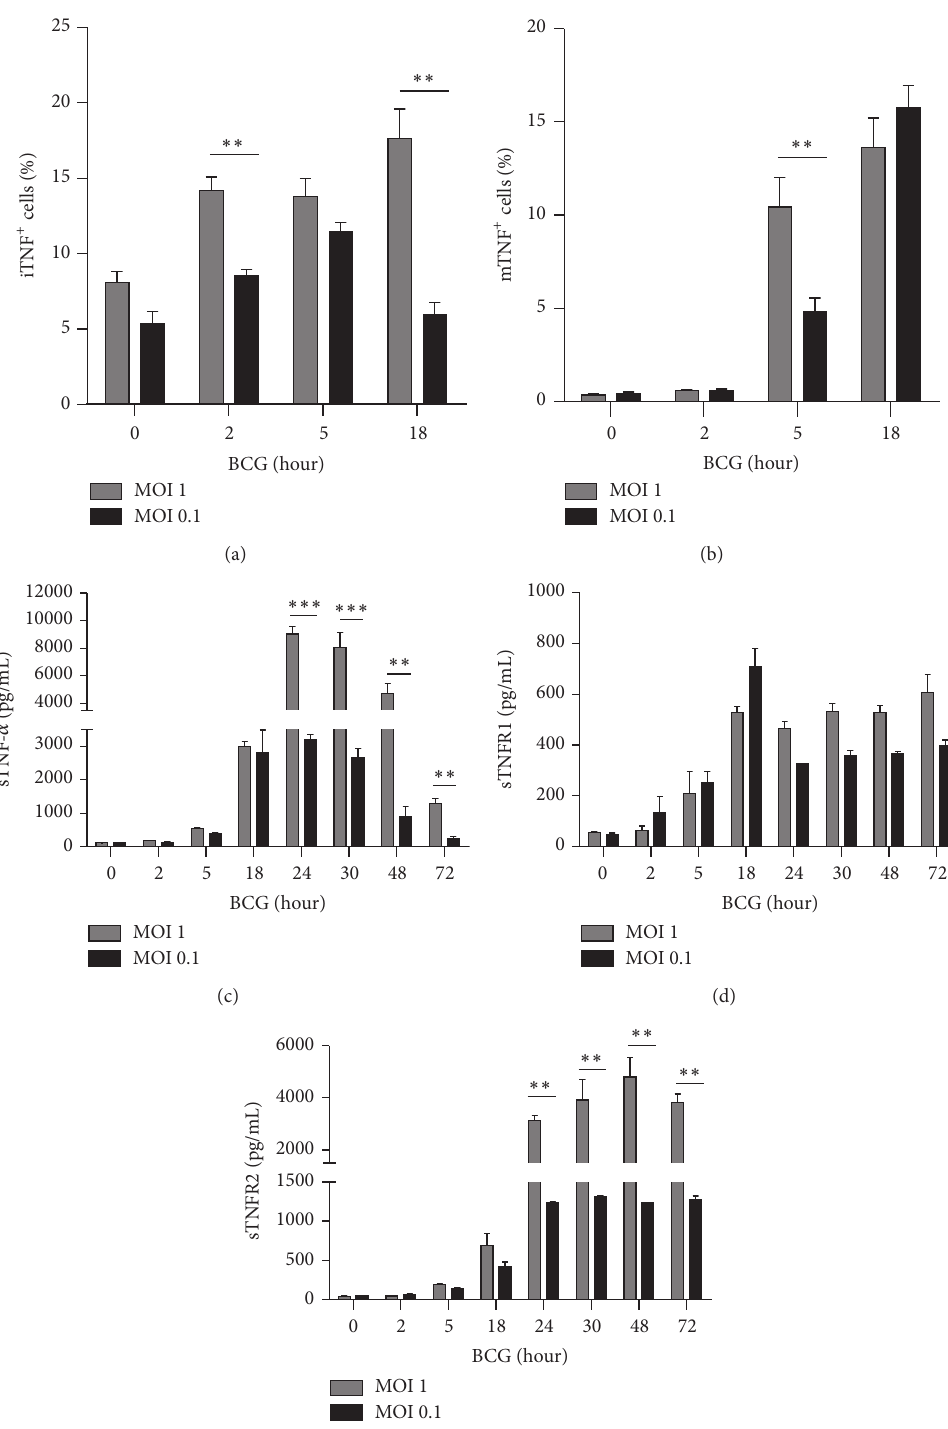
Figure 2: BCG infection at MOI 1 and MOI 0.1 activates TNF and soluble TNF receptors. (a) and (b) RAW macrophages were infected at MOI 1 or MOI 0.1 during 2, 5, and 18 h and stained for intracellular and transmembrane TNF with mAb against TNF. (c) Concentrations of soluble form of TNF were assessed by ELISA. (d) and (e) Soluble TNFR1 and TNFR2 were measured by ELISA in culture supernatant from RAW macrophages infected with BCG Pasteur at MOI 1 and MOI 0.1. Two-tailed unpaired Student’s 𝑡 -test was used to evaluate statistical differences. Bars indicate mean ± SEM from four independent experiments in each case. ∗∗∗ 𝑃 < 0.001 ; ∗∗ 𝑃 < 0.01 ; ∗ 𝑃 < 0.05